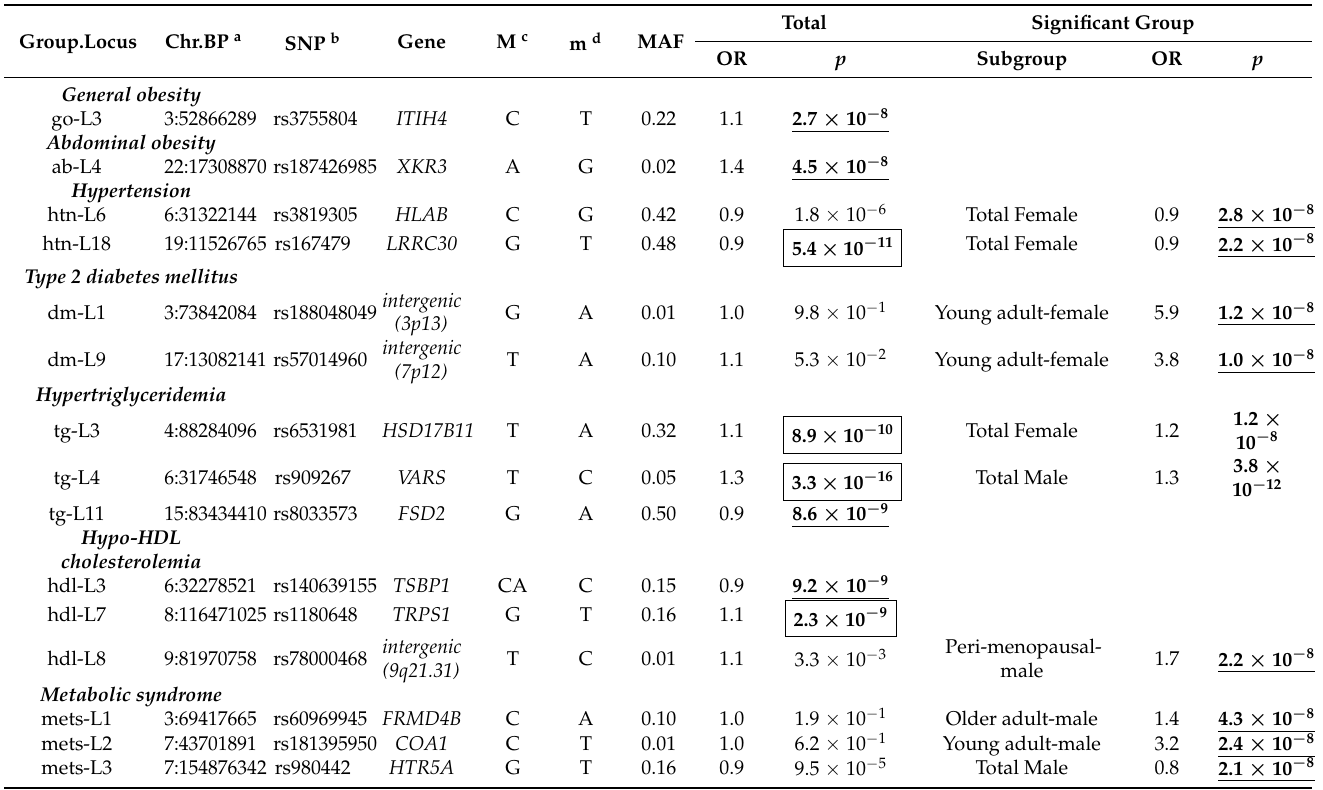
Table 4. Summary of newly identified loci among the significant results with metabolic factors based on menopausal